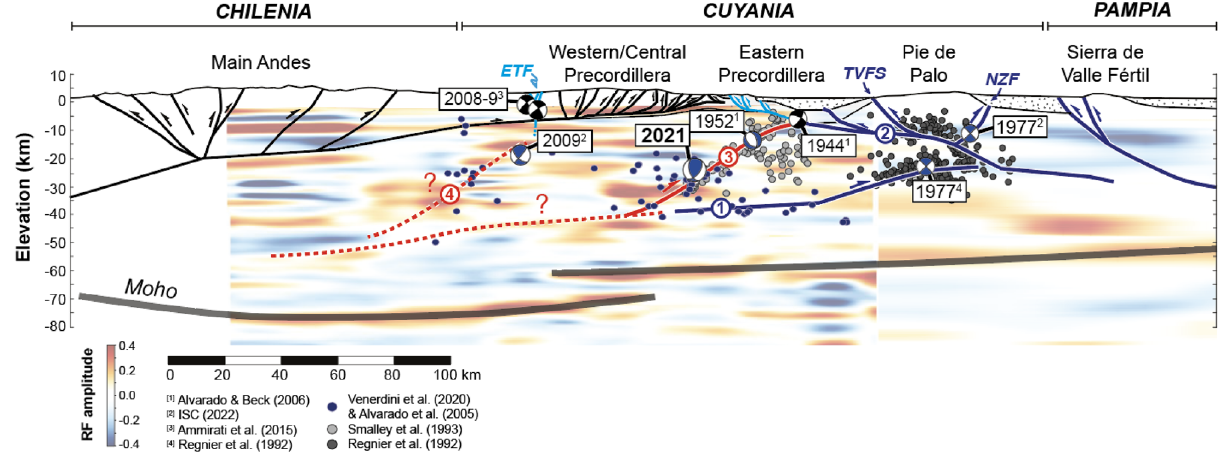
◦ Figure 5. Crustal-scale cross section of the Andean retroarc at ∼ 31.5 S highlighting regional seismicity (grey and blue circles), middle- to upper-crustal structures, and historically significant earthquake focal mechanisms. Emergent and subsurface fault geometries are modified from 6,9,11,18,20,25 . Receiver function data are from 39 . Fault- like structures inferred from geophysical data are marked with red and blue numbered circles and correspond to structural features described in the text. All earthquake focal mechanisms have been rotated into the cross section